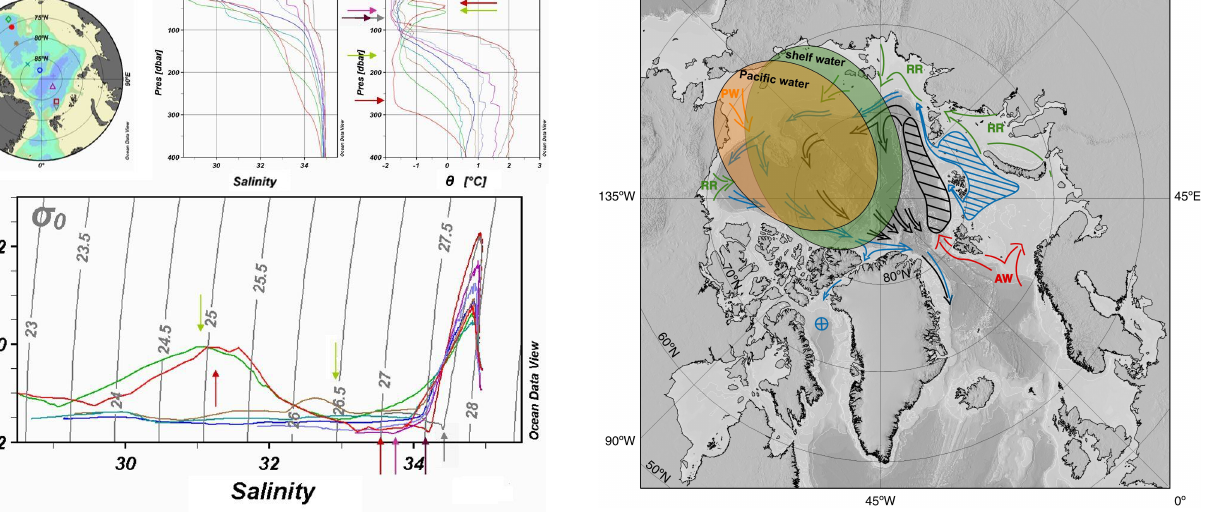
Fig. 8. Halocline features in the Arctic Ocean. The grey, dark red and magenta arrows indicate the temperature minimum created by the winter homogenization. The red arrows show on one station, the Near Surface Temperature Maximum (NSTM) due to seasonal heating (Jackson et al., 2010), the temperature maximum due to the inflow of Bering Strait Summer Water (BSSW) and a temperature minimum due to the presence of an (isolated?) eddy of Fram Strait branch lower halocline water. The green arrows show the tempera- ture maximum of the BSSW and the temperature minimum of the Bering Sea Winter Water (BSWW). Note that the NSTM is present also on the green station and that the temperature minimum of the winter homogenization is present above the BSSW maximum on both the green and the red station.